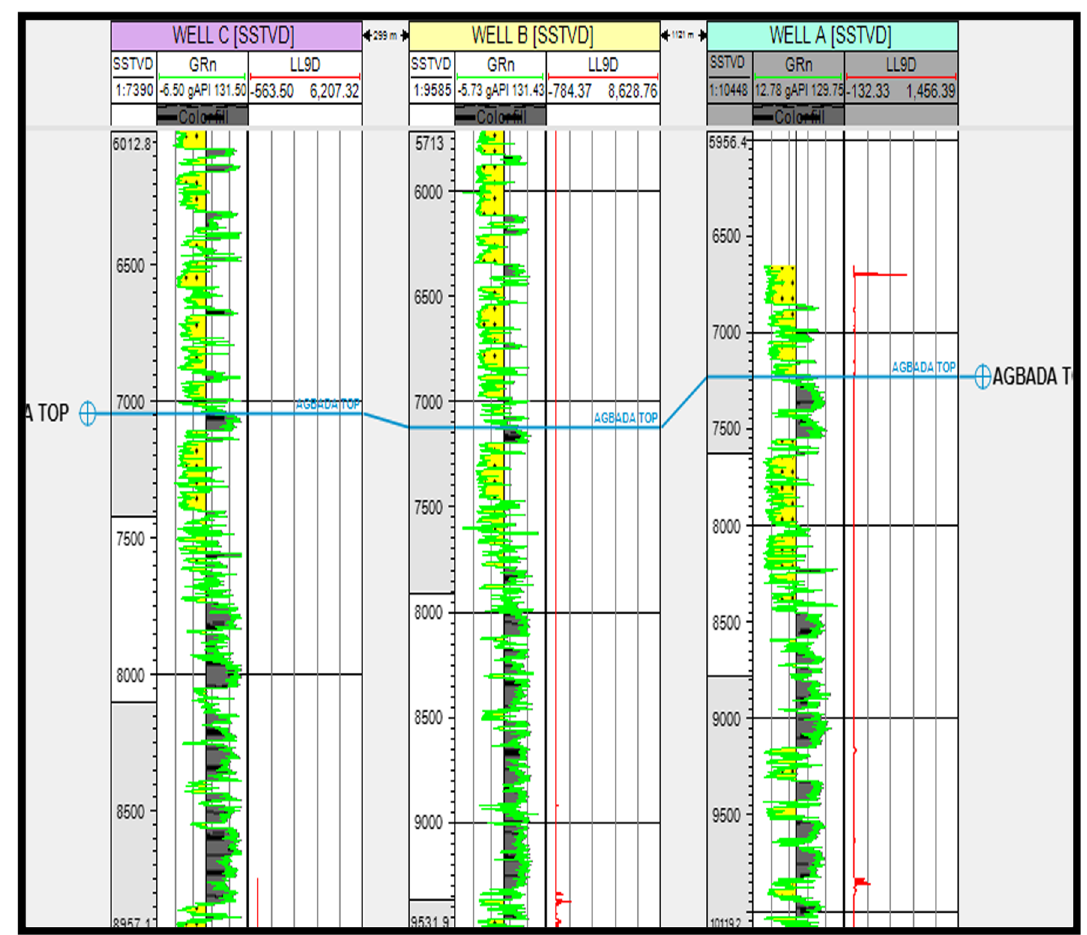
Fig. 3 Identification of Agbada top penetrated by well A, well B and well